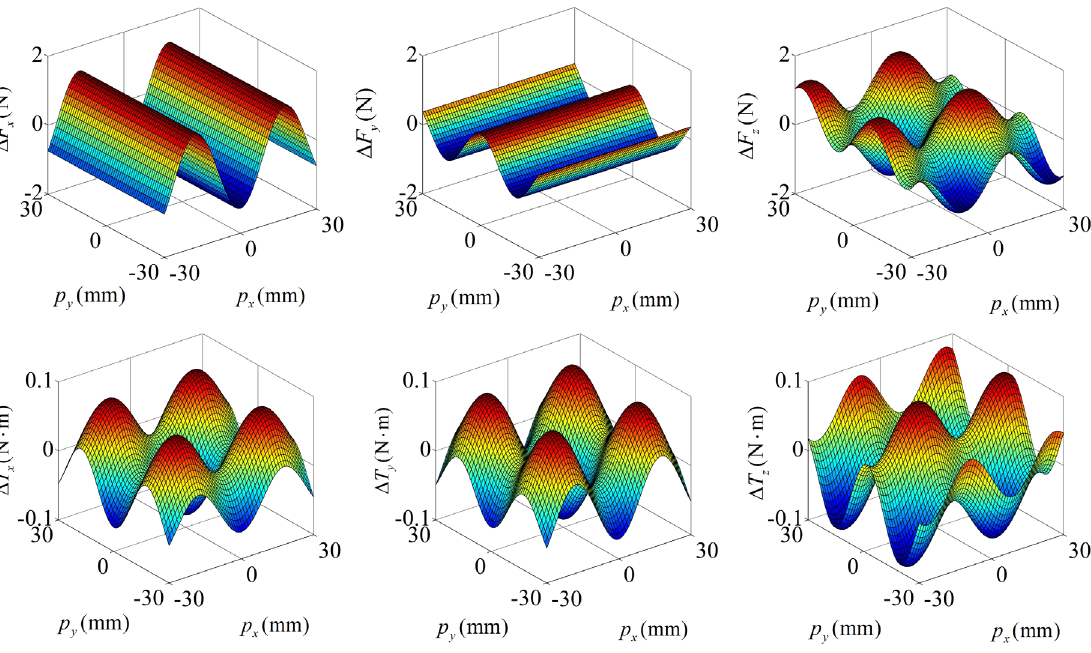
Figure 6. The force and torque errors between the deduced model and the harmonic model. The peak values calculated by the harmonic model are 91.93 N for F x , 45.93 N for F y , 91.97 N for F z , 5.75 N·m for T x , 6.21 N·m for T y , and 6.82 N·m for T z . It can be seen from Figure 6 that the error